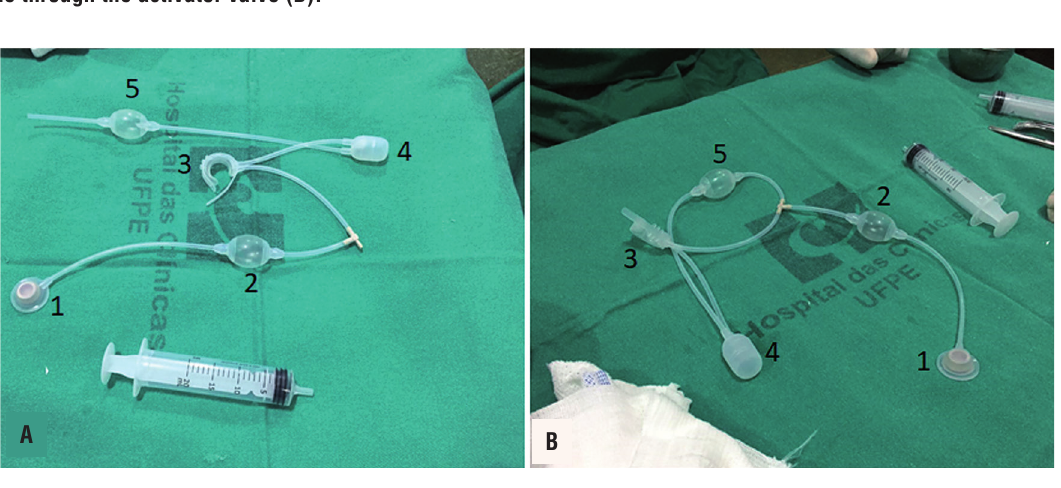
Figure 1 - Appearance of the disassembled BR-SL-AS 904 sphincter (A), consisting of the following parts: 1; 2; 4; and 5: constriction-pumping system and 3: activating valve. B) sphincter ready to be implanted after air removal by injecting 15ml of saline through the activator valve (B).